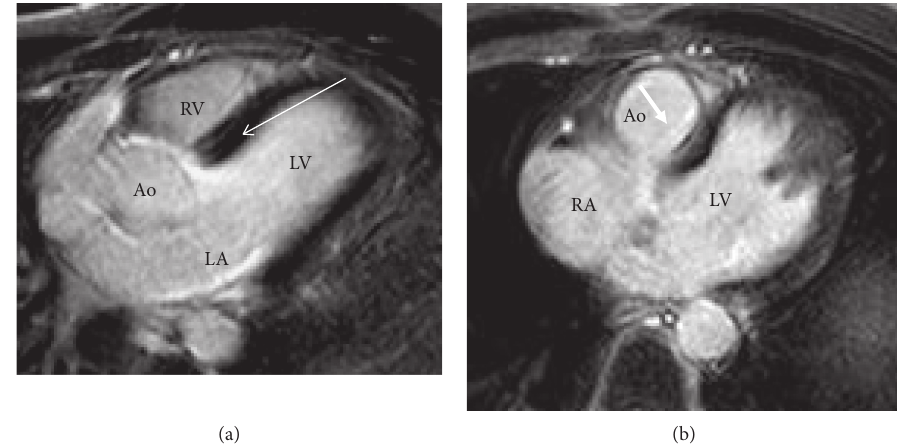
Figure 2: (a) and (b) Two males, aged 42 (a) and 48 (b) years, with idiopathic LBBB (a and b). In both cases, MRI shows late enhancement in the left posterior septum (arrows), possibly due to fibrosis involving the left bundle. Ao � aorta, RV and LV � right and left ventricles, respectively, RA and LA � right and left atria,